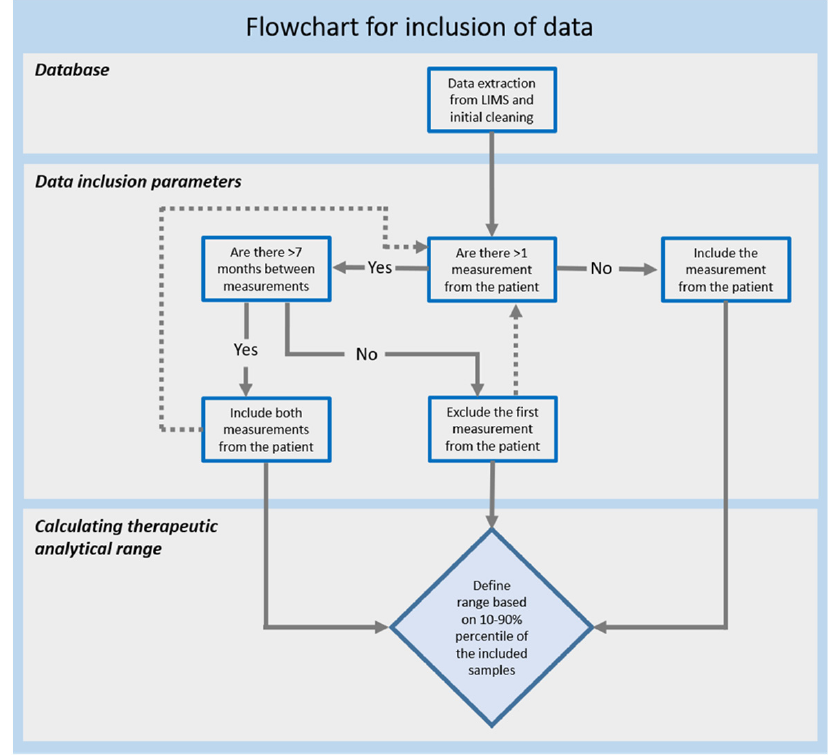
Figure 1. Flowchart of the TDM model used for qualification of data for calculating therapeutic analytical ranges.